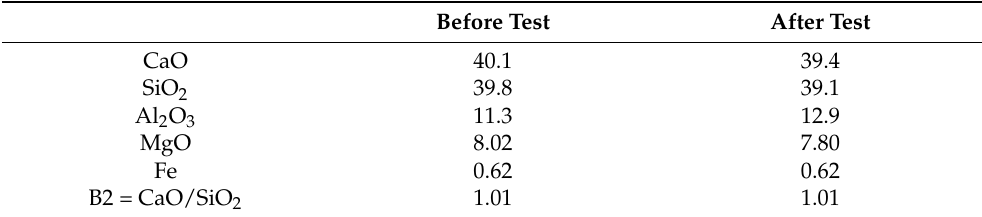
Table 6. SAF-like slag composition in wt.%; all values were measured as elements and converted to